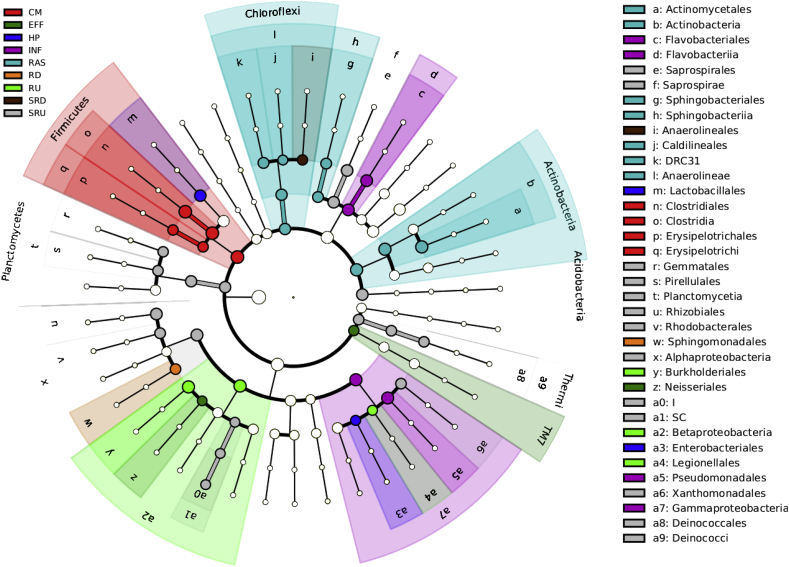
A linear discriminant analysis effect size (LEfSe) method identifies the significantly different abundant taxa of bacteria in all the sampling sites. The taxa with significantly different abundances among sites are represented by coloured dots, and from the center outward, they represent the kingdom, phylum, class, and order. The coloured shadows represent trends of the significantly differed taxa. Each coloured dot has an effect size linear discriminant analysis (LDA) score. Only taxa meeting an LDA significance threshold of >2 are shown. Samples labelled as follows: CM = community wastewater, HP = hospital wastewater (HP_A and HP_B), INF = WWTP influent, RAS = return activated sludge, EFF = WWTP liquid effluent, RD = downstream river water column, RU = upstream river water column, SRD = sediment river downstream, and SRU = sediment river upstream.